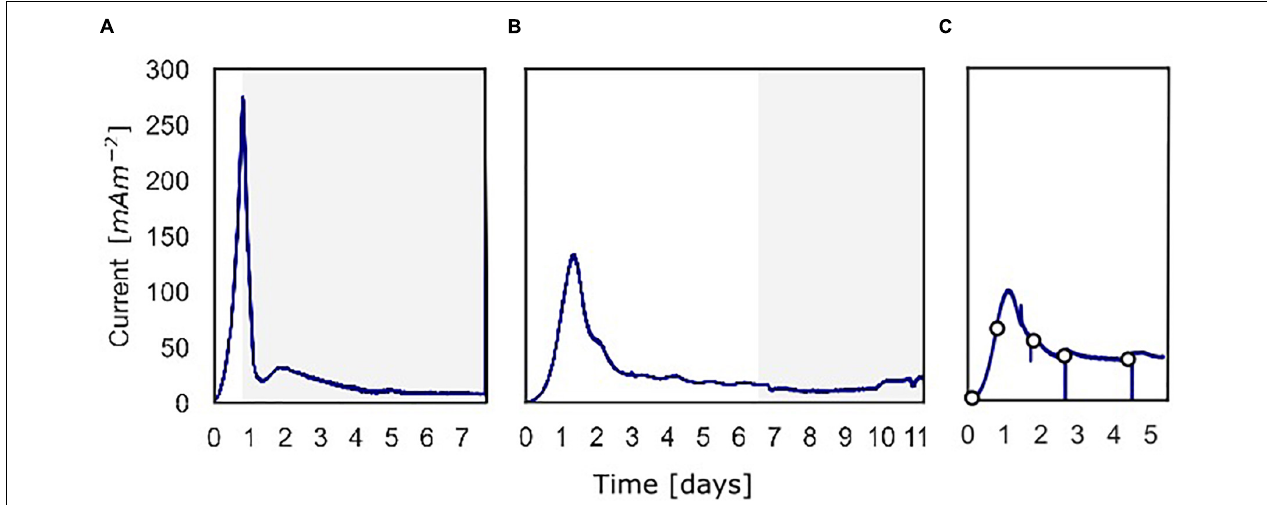
FIGURE 2 | The current density produced over time over the course of the three batch experiments. (A) Current density for the experiment in which 13 C-methane was used to follow the activity of “ Ca. Methanoperedens,” the part in which 13 C-methane was added and followed is shown in gray. (B) Current density for the experiment in which methane availability was varied to assess methane dependency of the current. The gray part shows when the experiment was performed shown in Figure 5 . (C) Current density for the experiment in which at different time points a polarization curve was used to assess dependency of methane oxidation on the